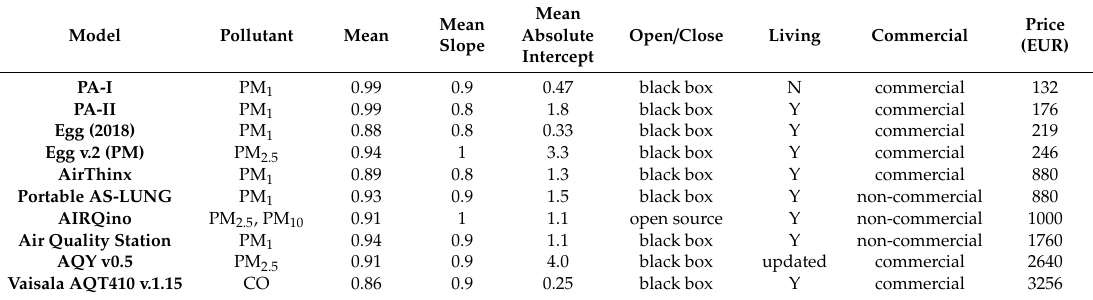
Table A4. Shortlist of SSys showing good agreement with reference systems (R 2 > 0.85; 0.8 < slope < 1.2) for daily